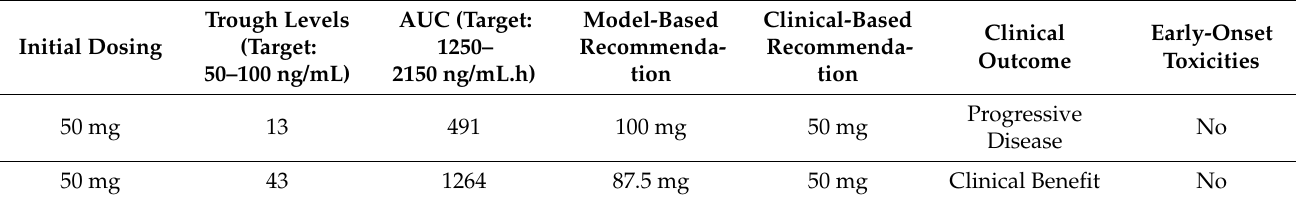
Table 5. Comparison between clinical-based change in dosing and proposed change in dosing by the model in the two patients with baseline exposures below the targets.